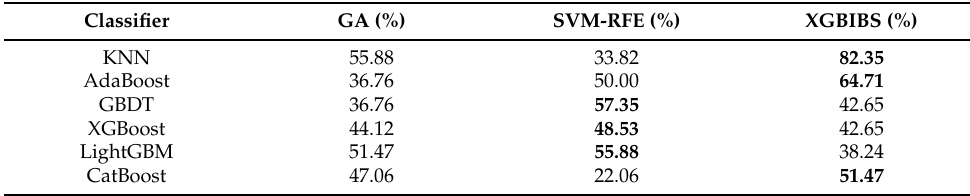
Table 13. Performance of feature selection algorithms on DR.